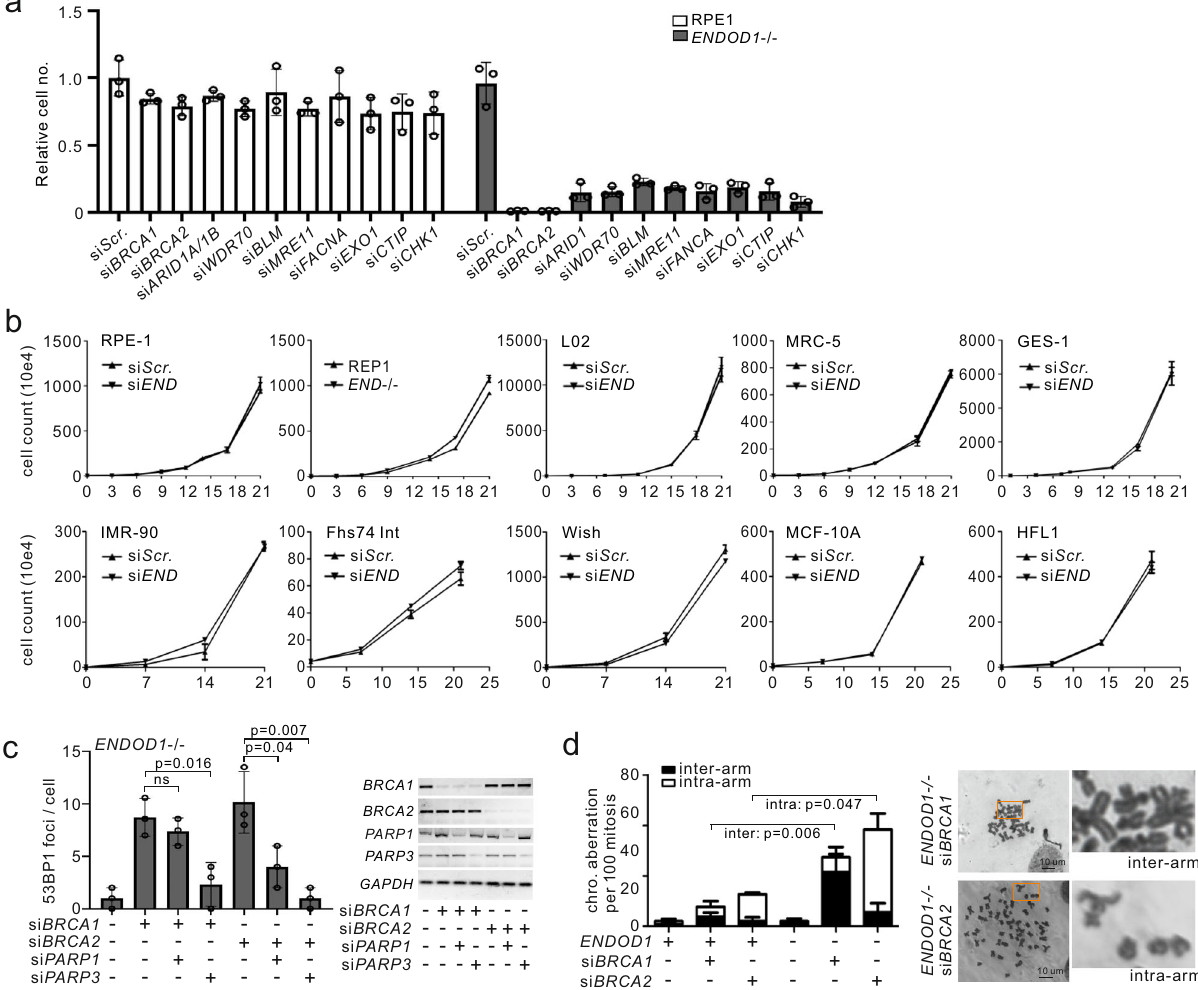
Fig. 2 Depletion of ENDOD1 causes SL with HRD. a Relative viability of ENDOD1 − / − and control RPE1 cells subjected to the indicated siRNA treatments. siRNA was transfected three times with three-day intervals. Cell viability was determined by CCK8 colorimetric assay. n = 3 biologically independent experiments. b Proliferation was quanti fi ed by haemocytometer cell counting over 3 weeks for the indicated immortalized non-cancerous cells with control siRNA (si Scr .) or si ENDOD1 treatment every 3 days. Control experiments using RPE1 and ENDOD1 − / − are shown in the fi rst two panels. c Left: quanti fi cation of 53BP1 foci in ENDOD1 − / − cells 72 h following treatment with the indicated siRNAs. n = 3 biologically independent experiments. Error bars: SEM. Signi fi cance test: two-tailed Student ’ s t test. ns: not signi fi cant. Right: semi-quantitative PCR showing knockdown ef fi ciency. d . Ablation of BRCA1 or BRCA2 in ENDOD1 null cells results in increased chromosome aberrations. Left: quanti fi cation of inter- and intra-chromosomal aberrations in RPE1 or ENDOD1 − / − cells treated with si BRCA1 or si BRCA2 . n = 3 biologically independent experiments. Error bars: SEM. Signi fi cance test: two-tailed Student ’ s t test. Right; representative si TP53 treated ENDOD1 − / − cells, but not control RPE1 cells (Fig. 4c) and the α -BrdU signal was sensitive to S1 nuclease treatment (Fig. 4d). The production of non-denatured α -BrdU staining upon si TP53 treatment of ENDOD1 − / − cells was reproduced with a second si TP53 , and could be eliminated by re- introducing ENDOD1 upon lentiviral infection (Supplementary Fig. 5c, d). Consistent with the production of ssDNA, S1 nuclease preferentially digested genomic DNA extracted from si TP53 treated ENDOD1 − / − cells when compared to relevant controls (Fig. 4e and Supplementary Fig. 5e). In contrast to these indica- tors of ssDNA lesions, DSB surrogate markers, γ H2AX and 53BP1 foci, were not signi fi cantly increased in G1-arrested ENDOD1 − / − cells 48 – 96 h after si TP53 transfection (Supple- mentary Fig. 5f, g). We conclude that concomitant loss of ENDOD1 and p53 functions results in the generation of ssDNA and cell death.